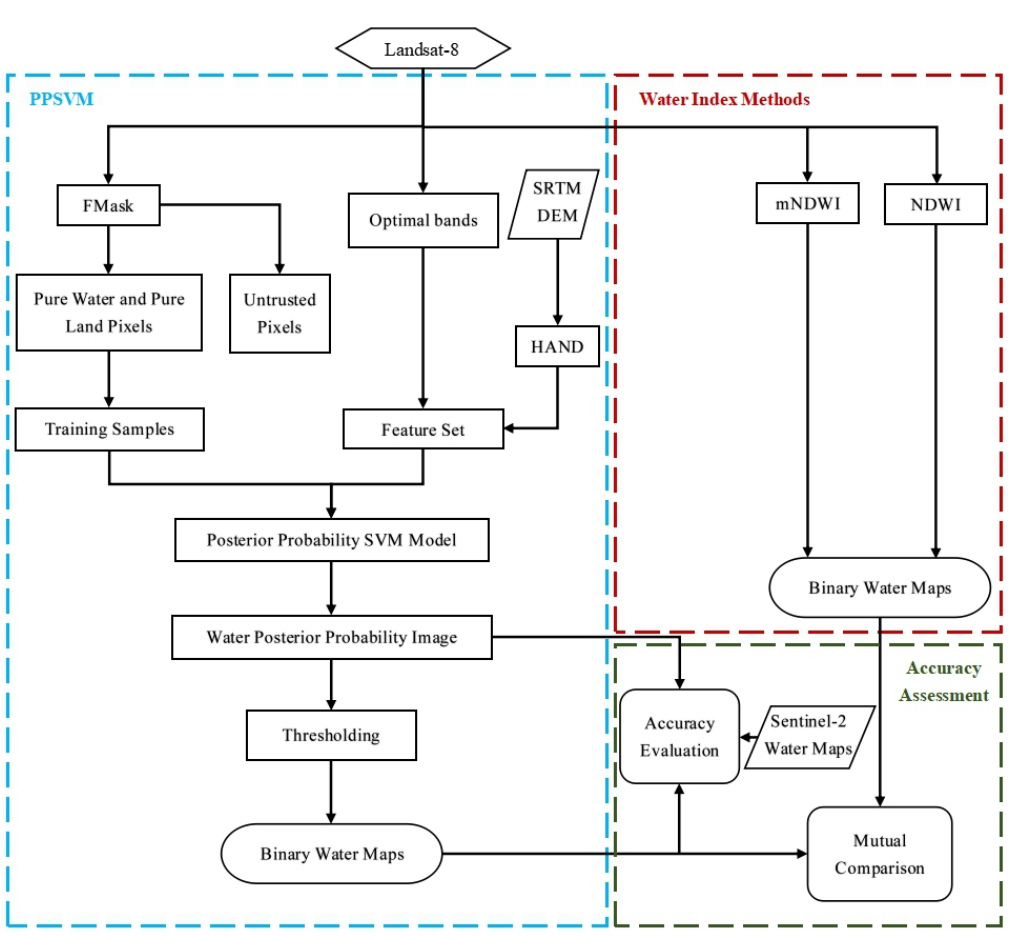
Figure 2. Flowchart of the methodology.